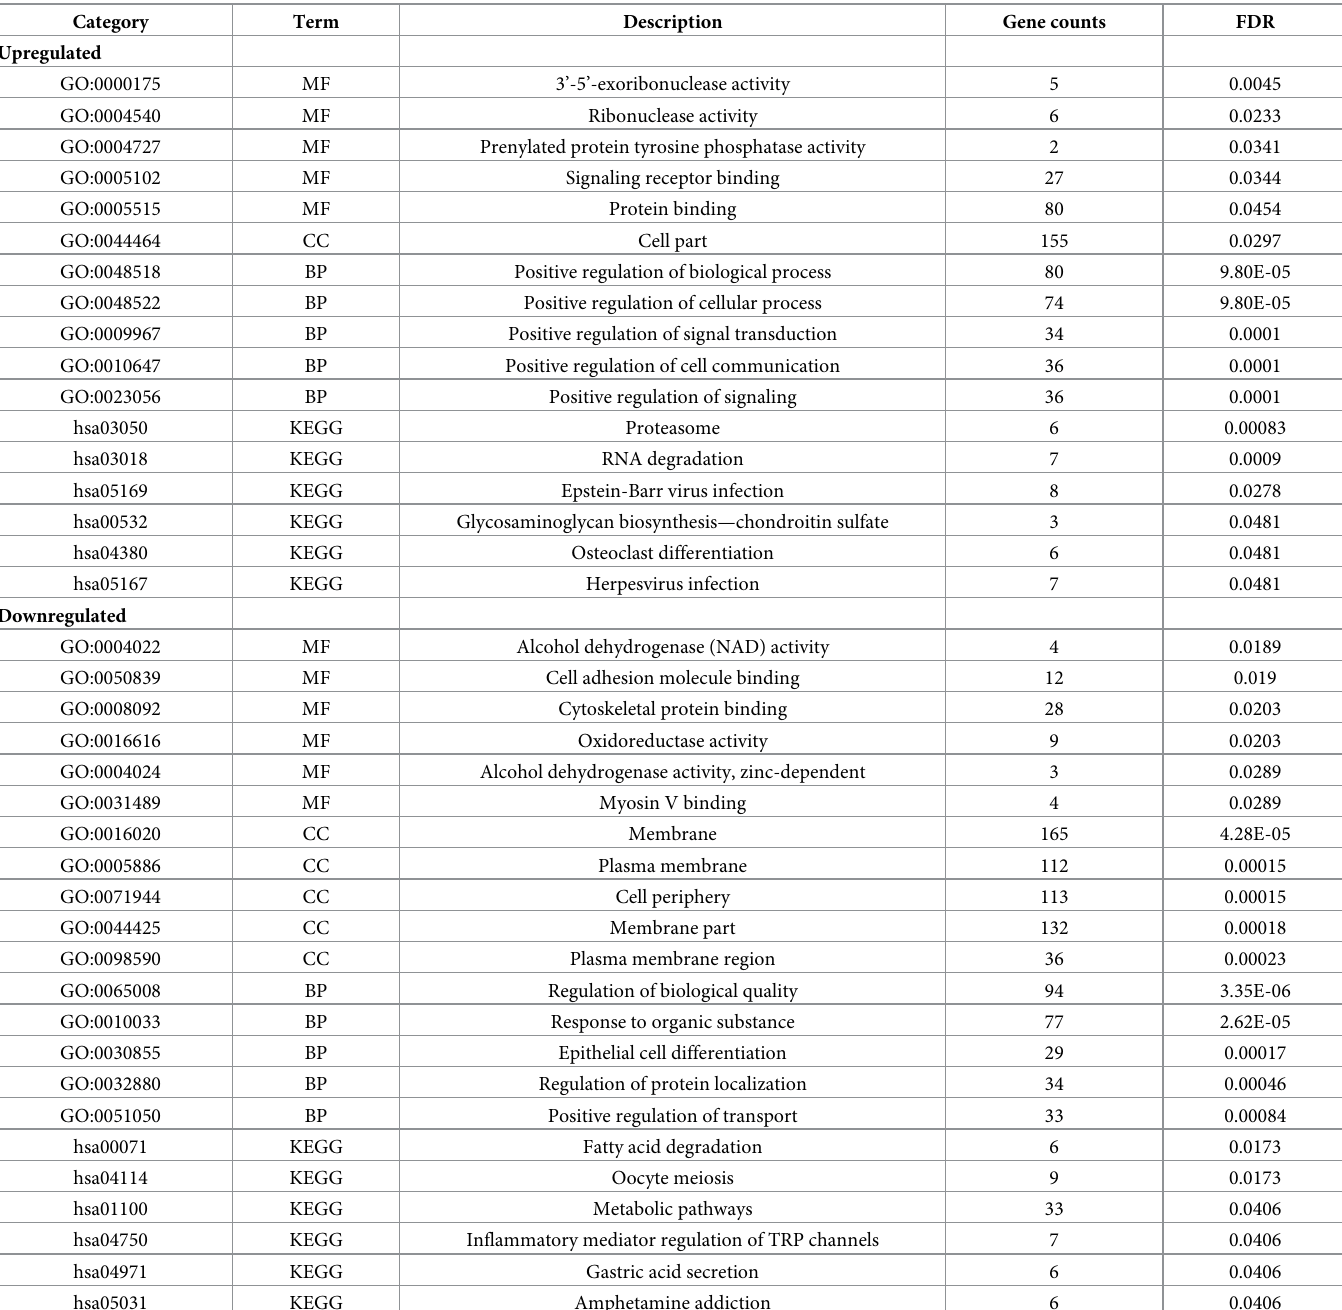
Table 2. Significantly enriched GO terms and KEGG